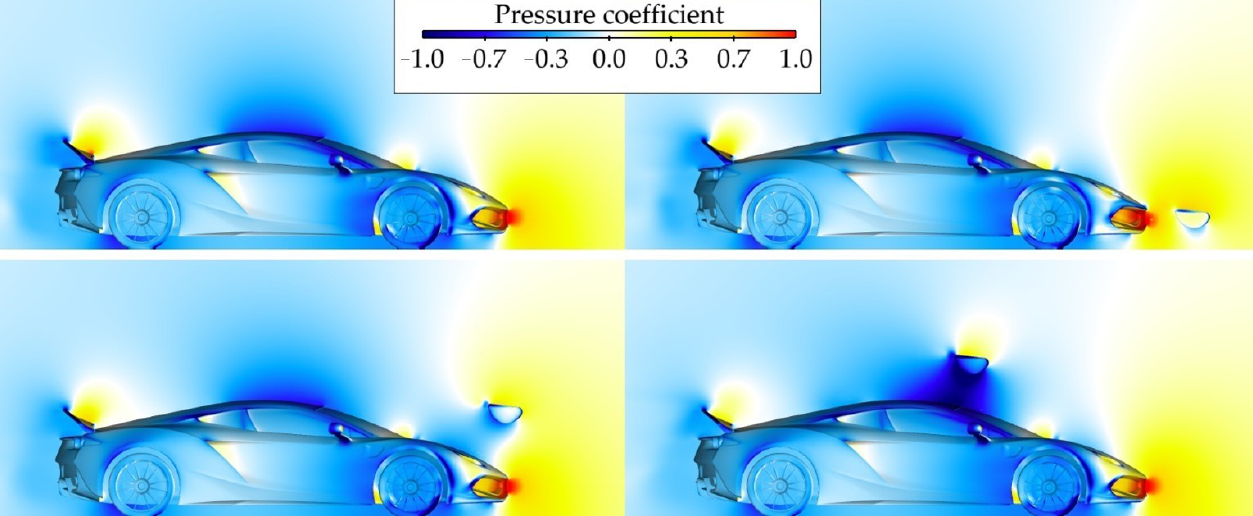
Figure 32. Pressure distributions on the symmetry plane for a vehicle without a front wing and a vehicle with three different wing positions (side view).